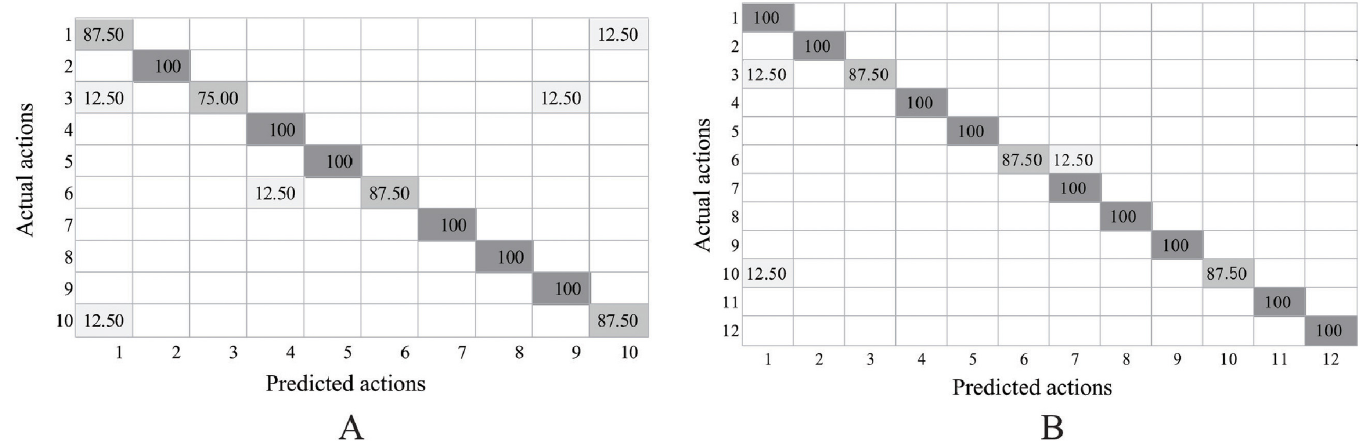
Fig 9. Average accuracy rate of the proposed model on i3DPost. The row and column represents action: walk(1), run(2), jump(3), bend(4), hand-wave(5), jump-in- place(6), sit-stand up(7), run-fall(8), walk-sit(9), run-jump-walk(10), handshake(11), pull(12). A and B illustrate experimental result on 10 and 12 actions, respectively.